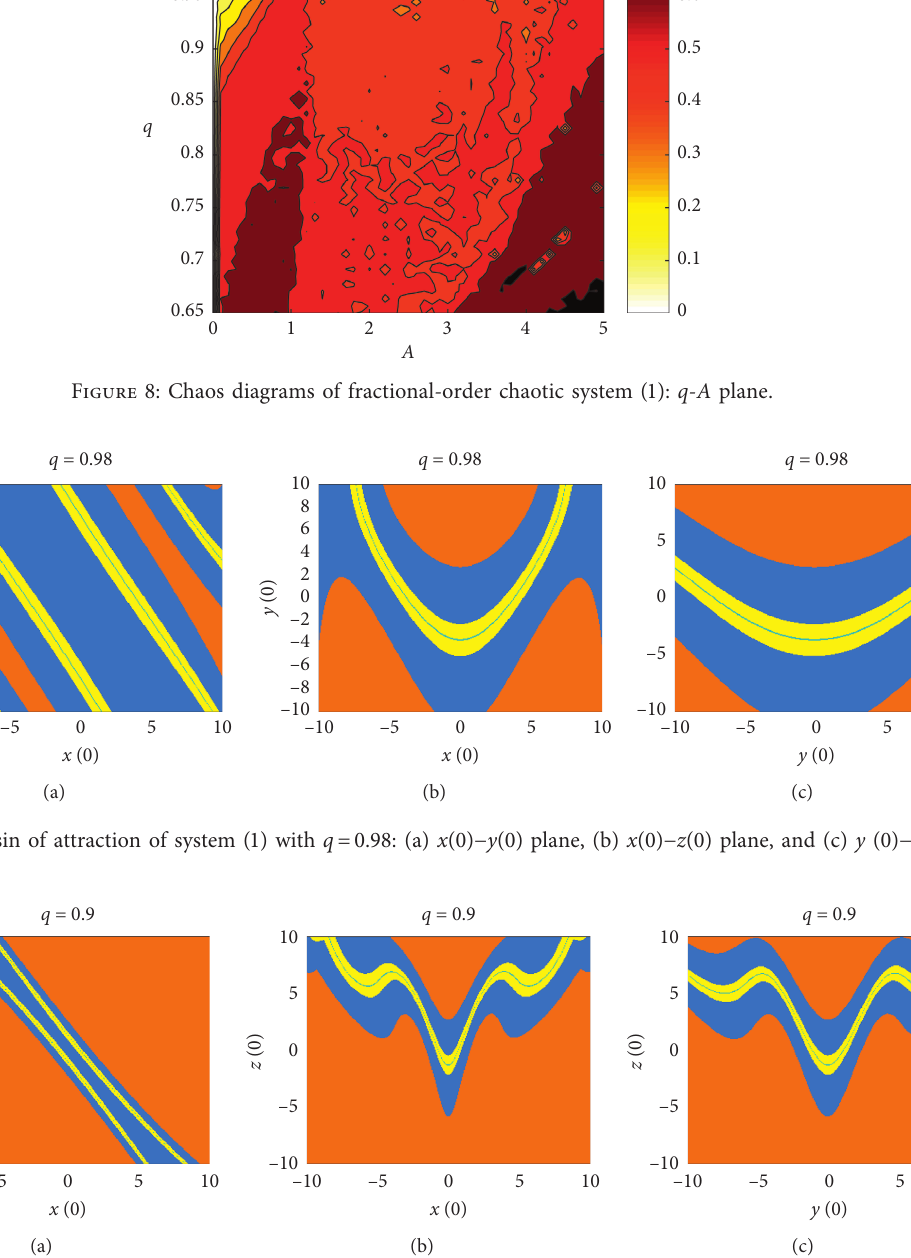
x Figure 10: The basin of attraction of system (1) with q � 0.9: (a) x (0) − y (0) plane, (b) x (0)- z (0) plane, and (c) y (0) − z (0)